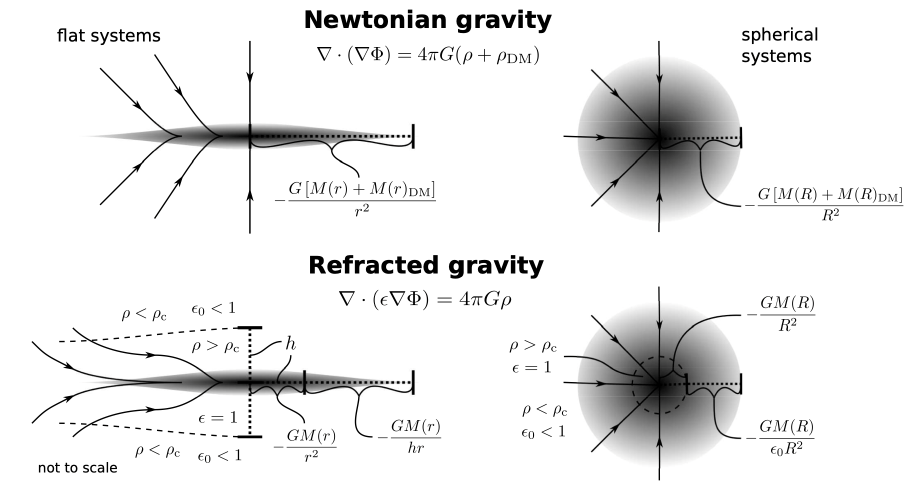
Figure 4. Comparison between the behaviour of Newtonian ( top panels ) and refracted gravity (RG) ( bottom panels ) gravitational fields for flat ( left panels ) and spherical ( right panels ) systems. The figure is taken from Figure 16 in